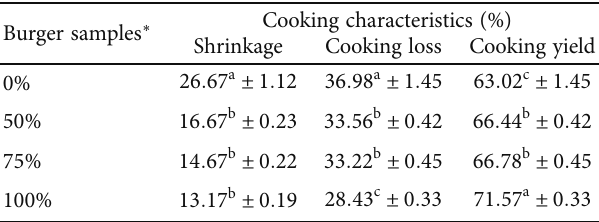
∗ Camel meat burgers partially substituted with UBDF pulp as a fat replacer. a,b,c No signi fi cant di ff erence ( p > 0 : 05 ) between any two means within the same column with the same superscripted